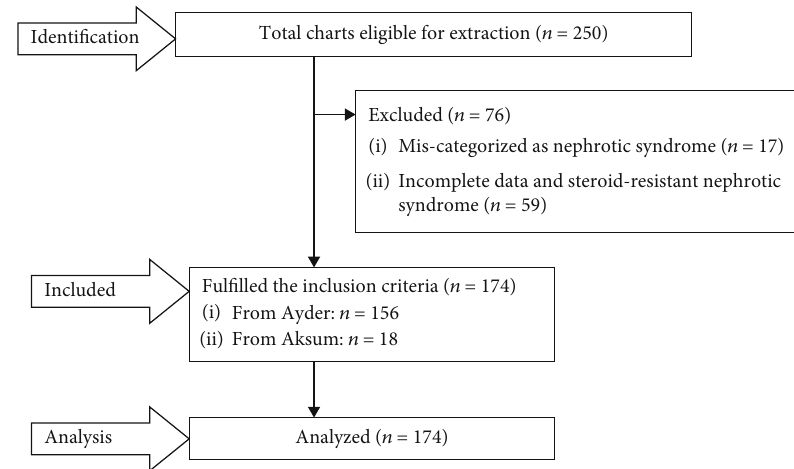
Figure 1: A fl ow chart of recruitment